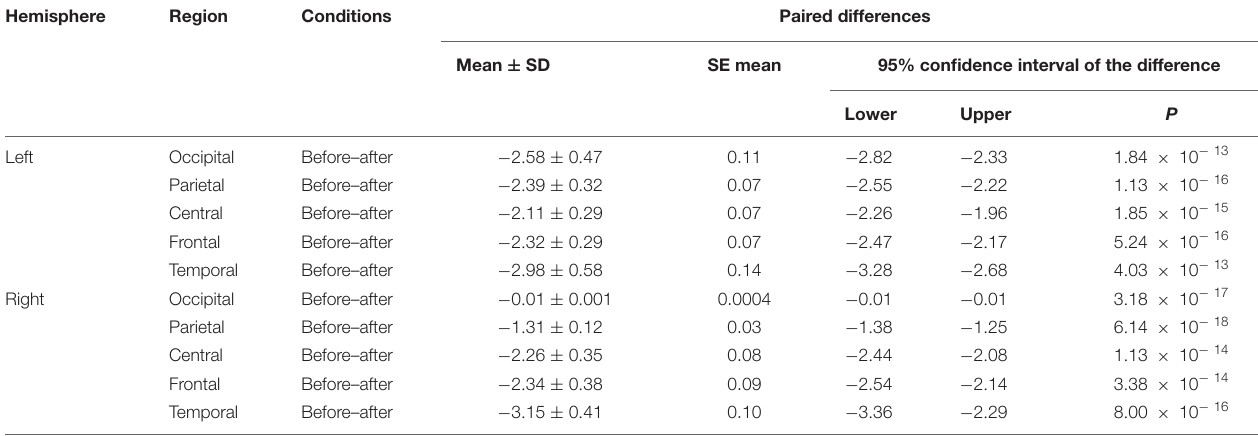
TABLE 8 | The results of paired t -test for average gamma power before and after each regional condition for healthy subjects. Hemisphere Region Conditions Paired differences Mean ± SD SE mean 95% confidence interval of the difference Lower Upper P Left Occipital Before–after − 1 . 99 ± 0 . 07 Parietal Before–after − 2 . 39 ± 0 . 33 Central Before–after Frontal Before–after Temporal Before–after Right Occipital Before–after